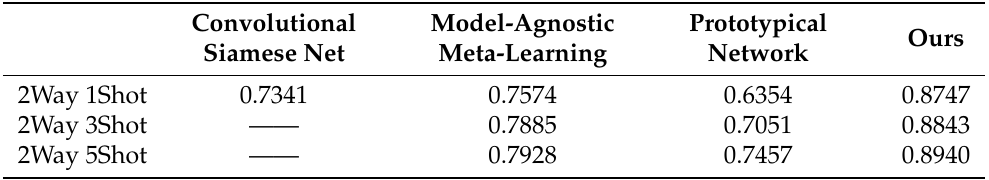
Table 2. The classification results when comparing our method with three classical few-shot learning